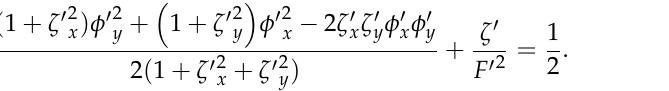
and ζ (cid:48) x x